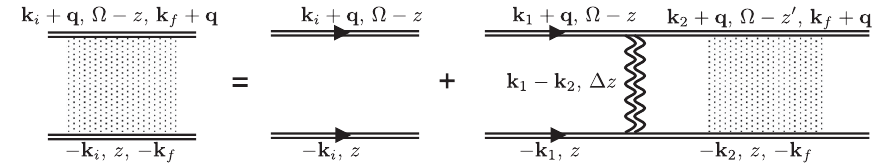
FIG. 5. Feynman diagram representation of the two-particle Dyson equation under the screened ladder approximation. The top and bottom propagators denote the Green ’ s functions of electrons and holes, respectively. The wiggly line denotes the dynamically screened attractive potential. This diagram sums over all processes through which the electron-hole pair is repeatedly scattered by the attractive